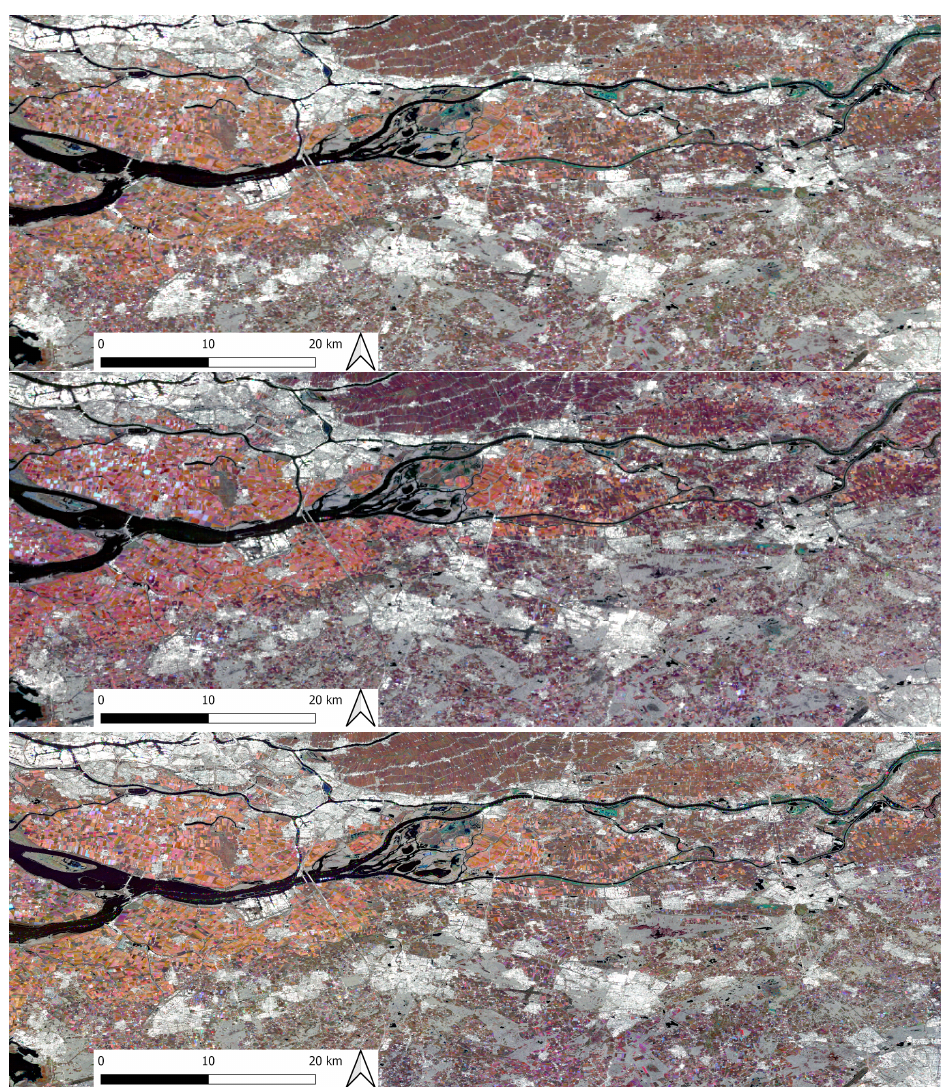
Figure 5. Results of use case 1, executed at GEE, VITO, and JRC (from top to bottom ).